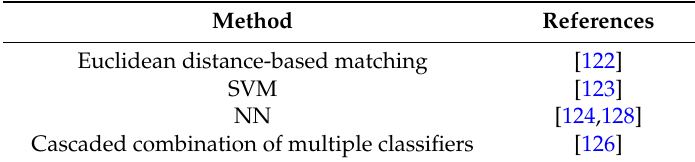
Table 13. Methods for classification in the serial number recognition process flow.